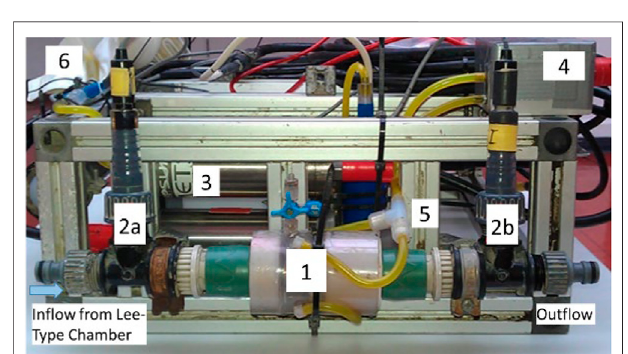
FIGURE2| Front viewoftheSGD-MRT: 1.Flow-throughunit (FTU), 2a, b.Conductivityprobeatthein fl owandout fl owoftheFTU,3.Circulationpump to stir fl uids inside the FTU, 4. Tracer injection unit (TIU), 5. Three-way tube connector for injection of the saline solution into the FTU, 6. Flexible bag (300 ml) fi lledwithsalinewaterappliedforthetracerinjectionintotheFTU.The carrier frame size is L 45 × W 45 × H 18 cm with a weight of about 8